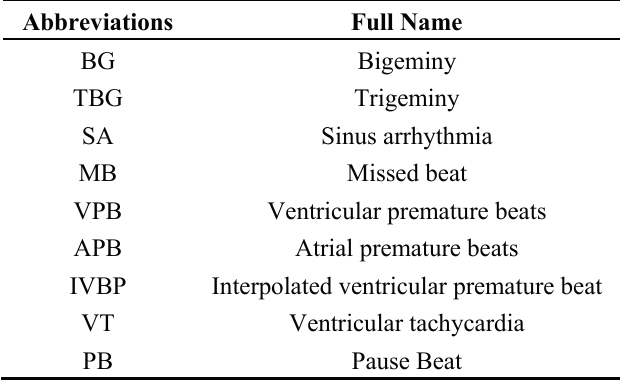
Figure 9. Screenshot of smartphone ( a ) abnormal ECG signal; ( b ) the brief report. Table 9. Abbreviations in the report.